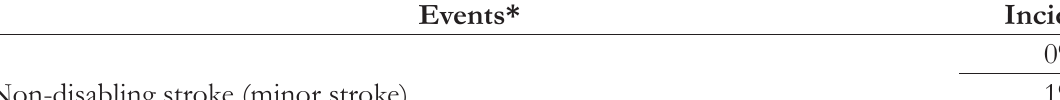
Table 1. Events and Incidences Used in Preference